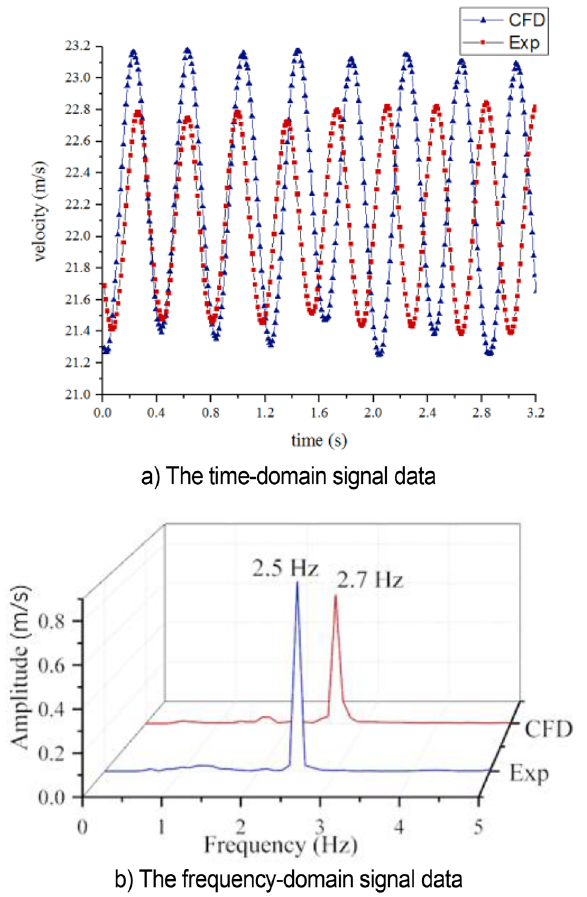
Figure 10. The velocity at the